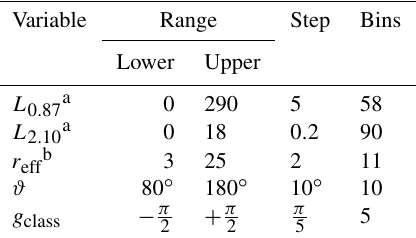
Table 1. Variables, range, and step size into which simulated radi- ances are binned to obtain a multidimensional histogram which is then used as a lookup